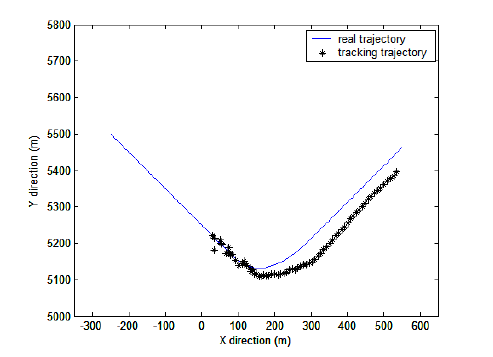
Fig. 3. Trajectory comparison.